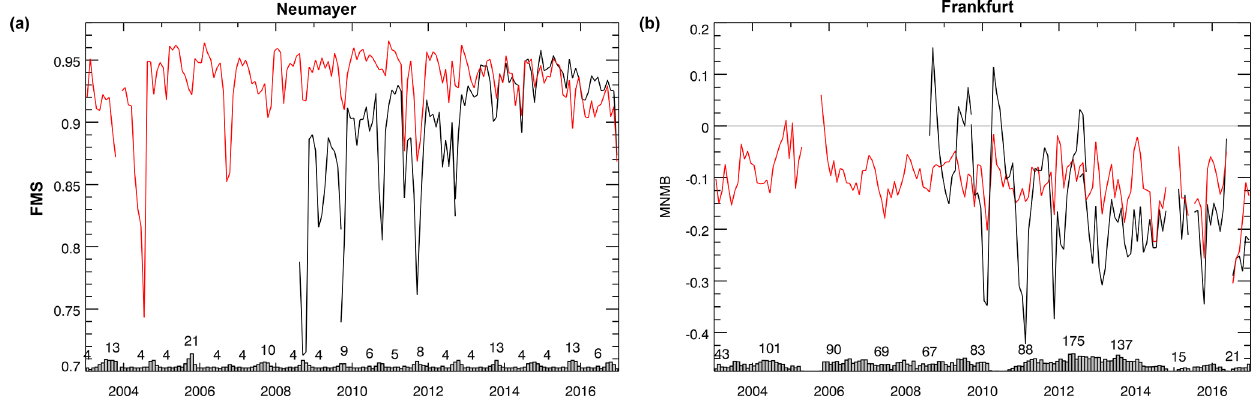
Figure 1. Time series from 2003 to 2016 of (a) FMS score of ozone at Neumayer (1000–3hPa) against ozone-sondes (see Sect. 4.1) and (b) MNMB of CO in the lower troposphere (1000–700hPa) at Frankfurt am Main airport against IAGOS aircraft data (see Sect. 4.2) from the real-time CAMS system (black) and CAMSRA